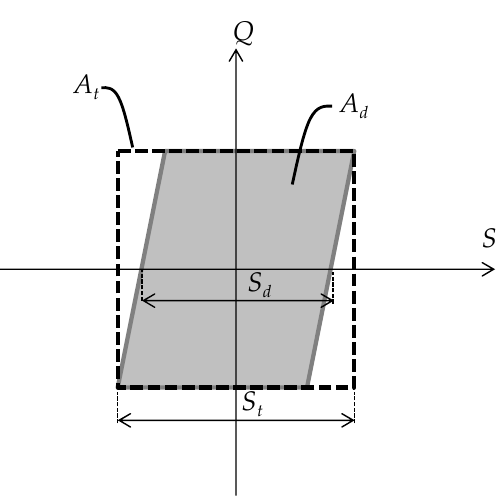
Figure 6. Fretting loop. Q and S denote a tangential force and a relative displacement, respectively. A t and A d present total energy and dissipated energy. S t and S d mean total displacement and actual sliding distance,